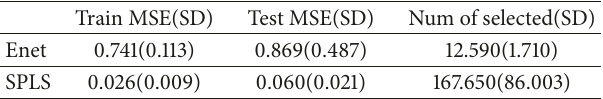
Table 4: The results on “gasoline” data set based on 100